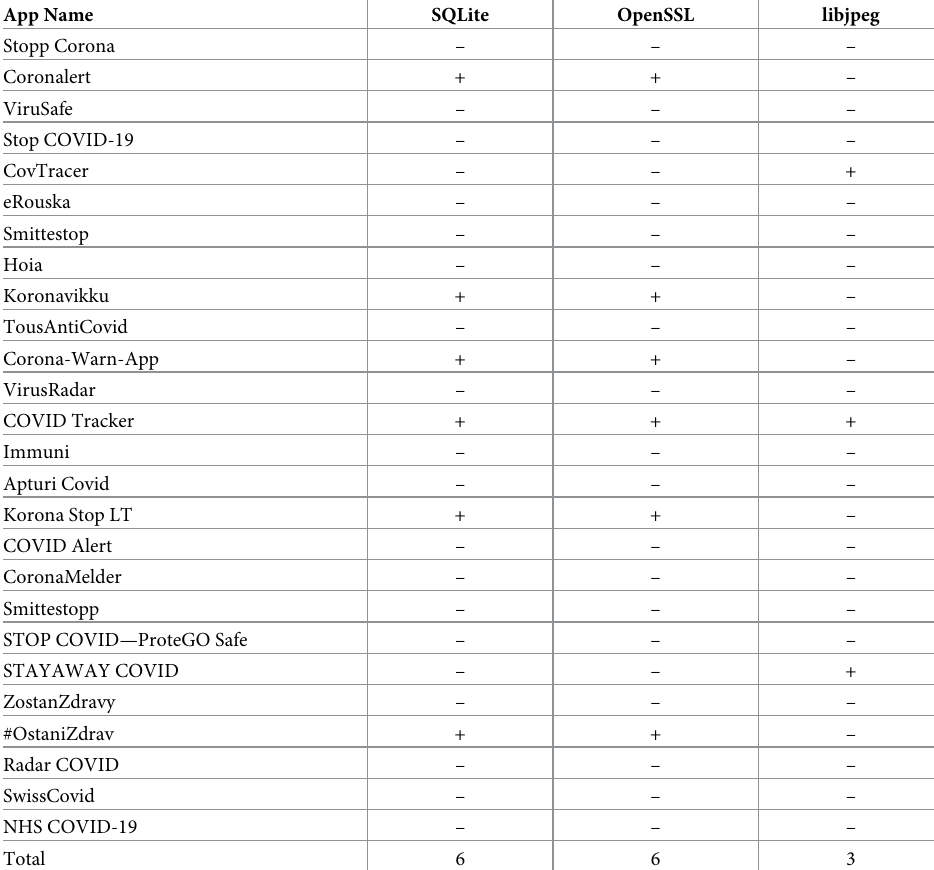
Table 9. Outdated third-party software components per